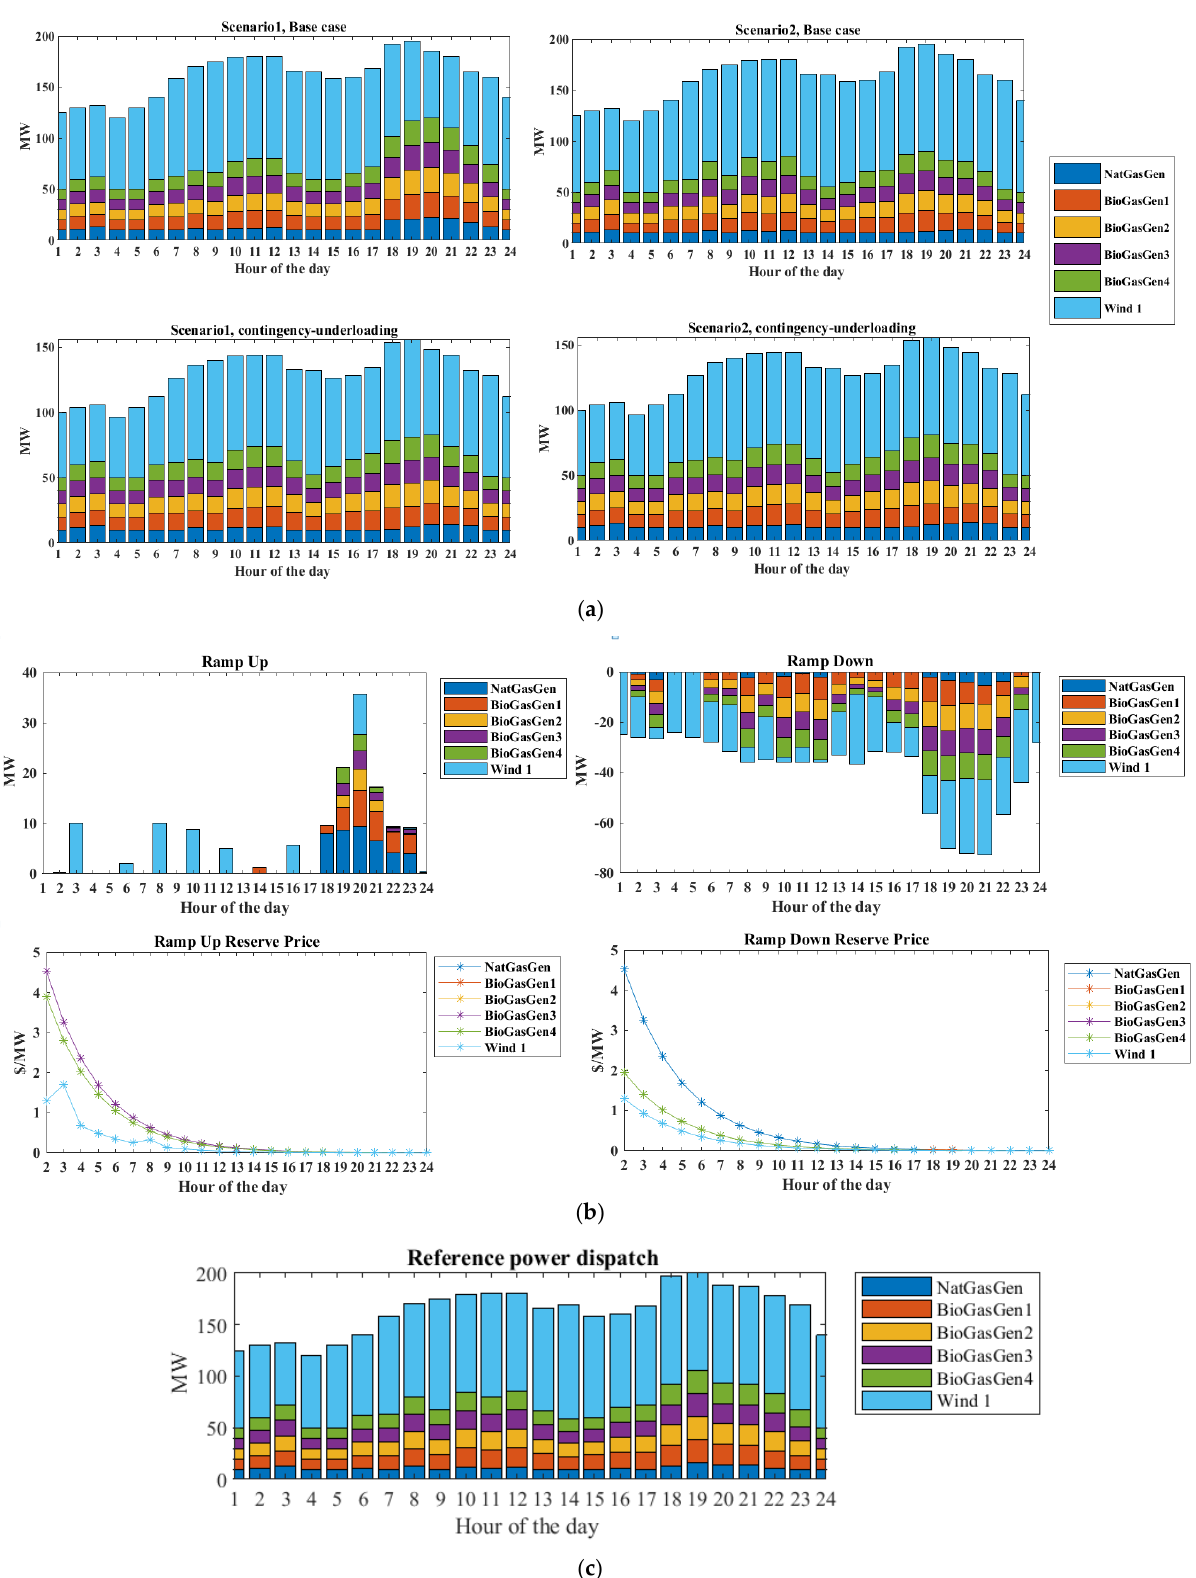
Figure 15. ( a ) Power generation for two base cases and respective probabilistic contingency cases created using transition probabilities. ( b ) Ramp-up/down reserves injected and their prices during contingency. ( c ) Reference power dispatch during contingency.